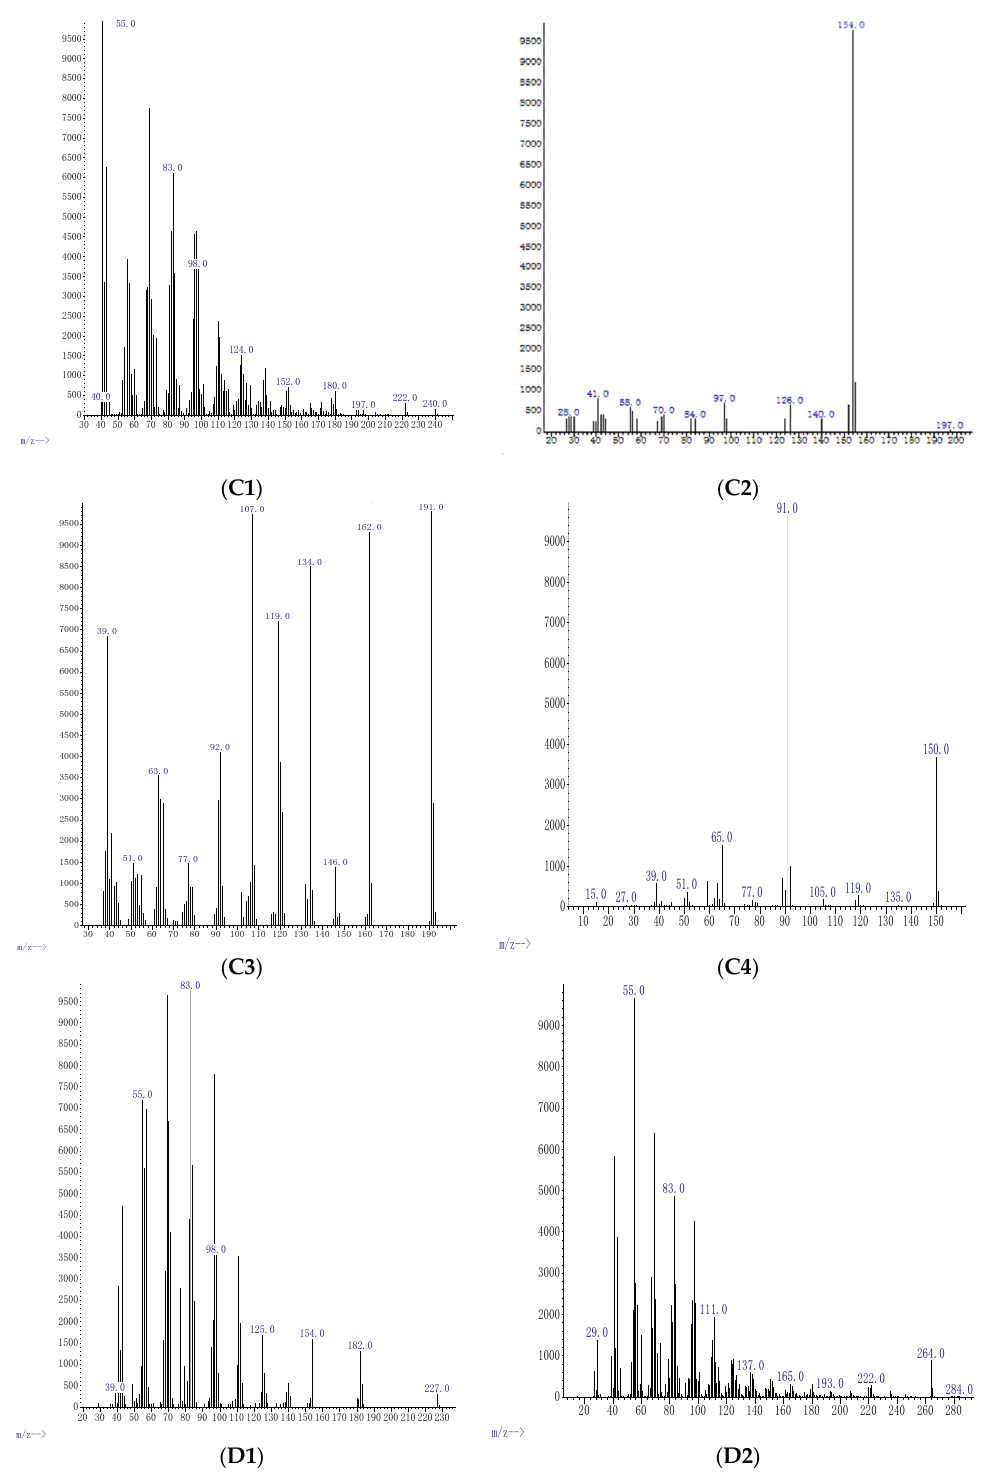
Figure 4. GC-MS/MS mass spectra of the crude extract prepared from the medium of the endophytic fungus P. heveicola cultured with valproic acid as an epigenetic modifier at different concentrations. ( A ) 0.5 µ g/mL cyclopropane. ( B ) 5 µ g/mL: Oxathiazole 2 thione ( B1 ) and pyrrolo[-1,2-a] pyrazine-1,4-dione,hexahydro-3,2-methyl ( B2 ). ( C ): 25 µ g/mL cyclopen- tadecanone ( C1 ); oxazole ( C2 ), 4-ethyl 4,5-dihydro 2,2-hydroxy phenyl ( C3 ); and benzene acetic acid ( C4 ). ( D ) 50 µ g/mL chloroacetic acid ( D1 ) and cis-vaccenic acid ( D2